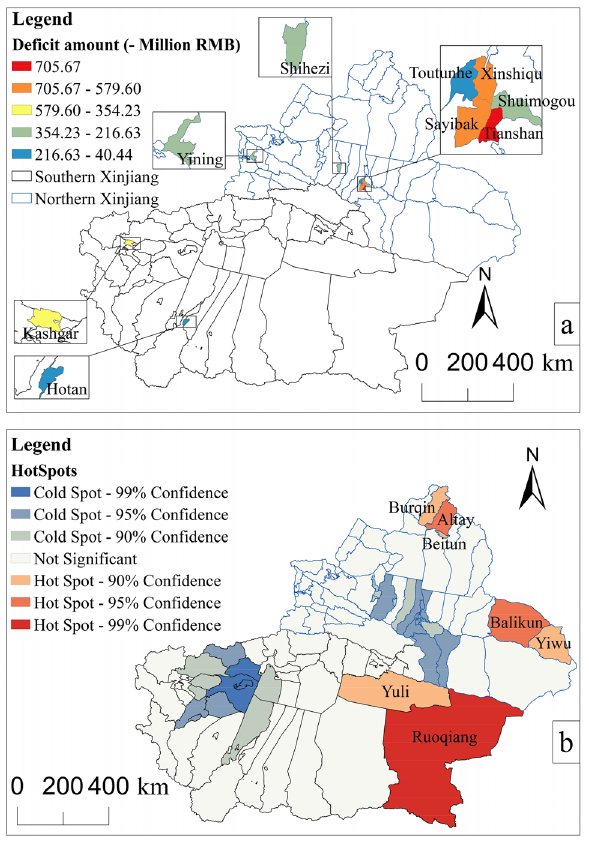
Figure 10. Carbon sequestration ecological deficit areas ( a ) and hotspots ( b ). Map generated with ArcGIS 10.8 (ESRI). URL: https:// suppo rt. esri. com/ en/ Produ cts/ Deskt op/ arcgis- deskt op/ arcmap.